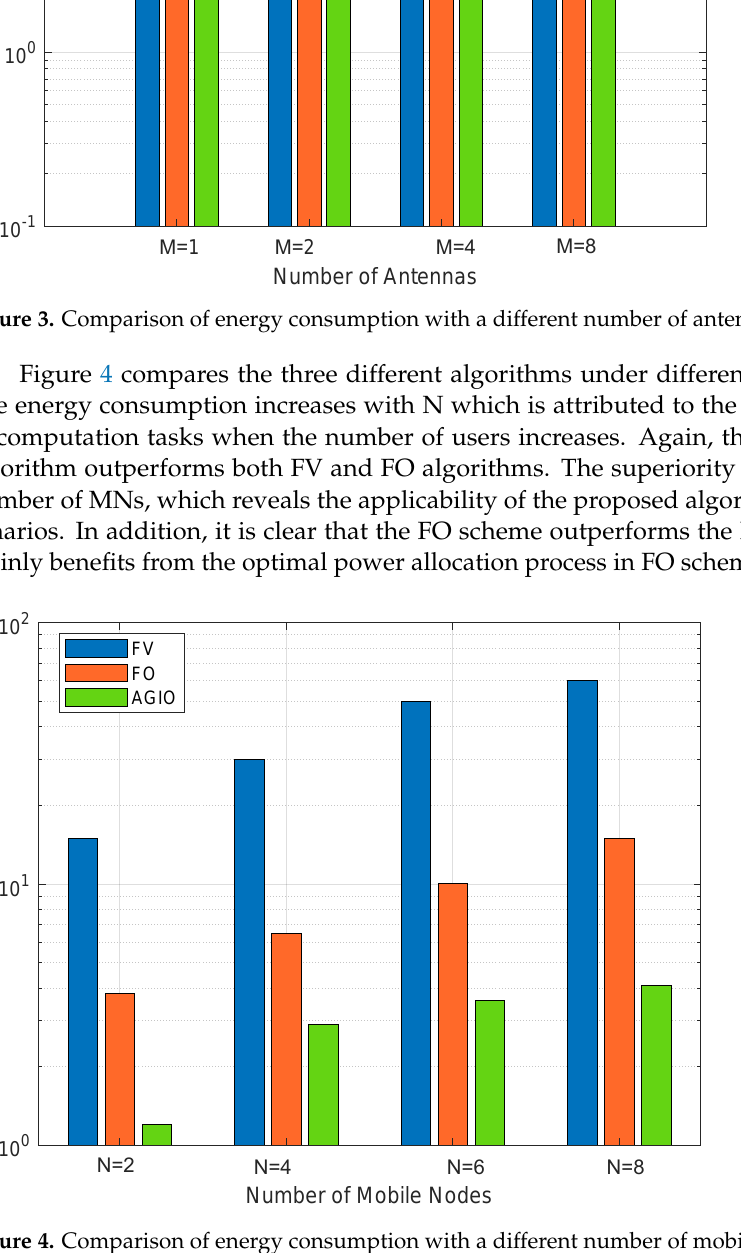
Figure 4. Comparison of energy consumption with a different number of mobile